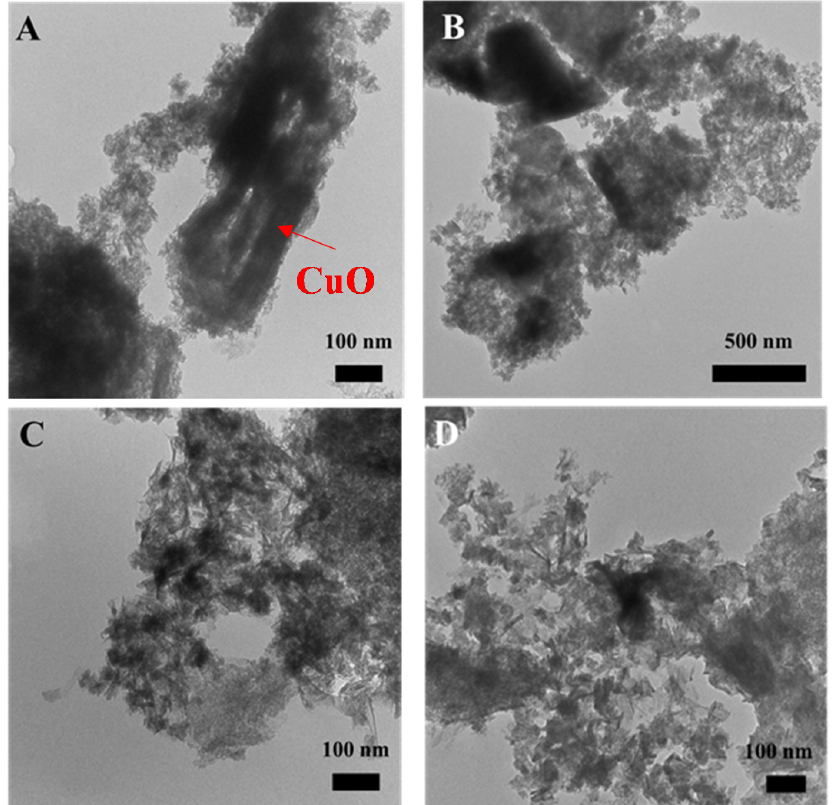
Figure 4. TEM images of the Cu-Ni/Al 2 O 4 samples synthesized for different hydrothermal times: ( A ) 0 h, ( B ) 12 h, ( C ) 24 h, and ( D ) 48 h. (Note that all samples were obtained from a calcination at 600 °C).